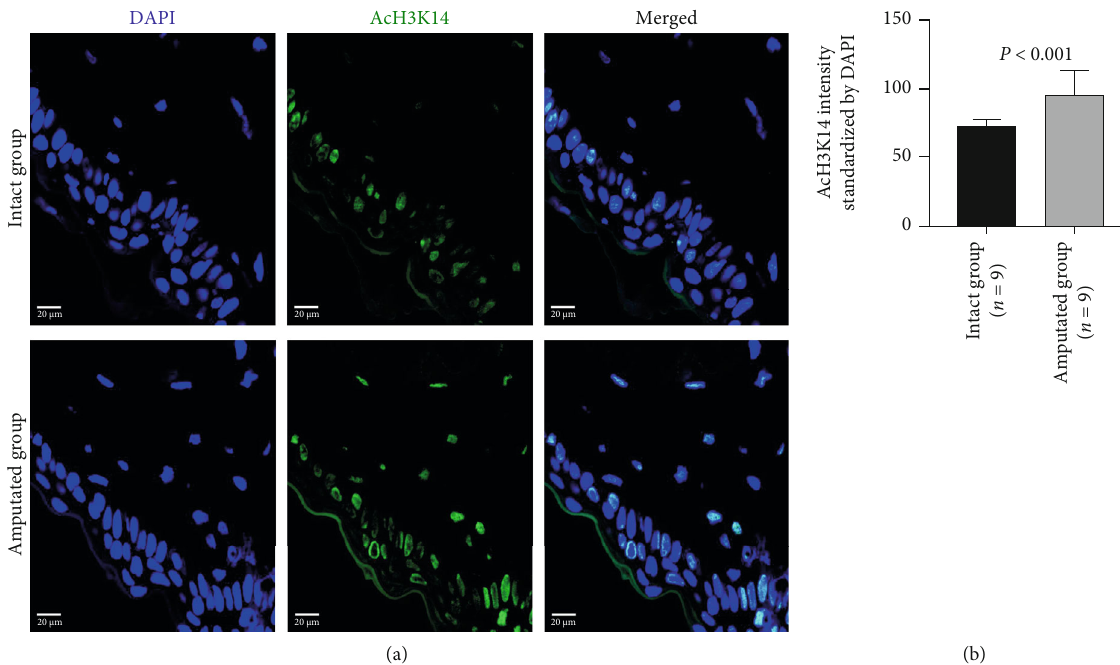
Figure 4: Immunohistochemical analysis on the acetylation of H3K14 in tissue cells 3 days after amputation. Representative images (a) and quantitative data (b) show the expression of acetylated H3K14 (AcH3K14) in intact tails and amputated tails. Quantitative data was normalized by DAPI. Scale bar: 20 μ